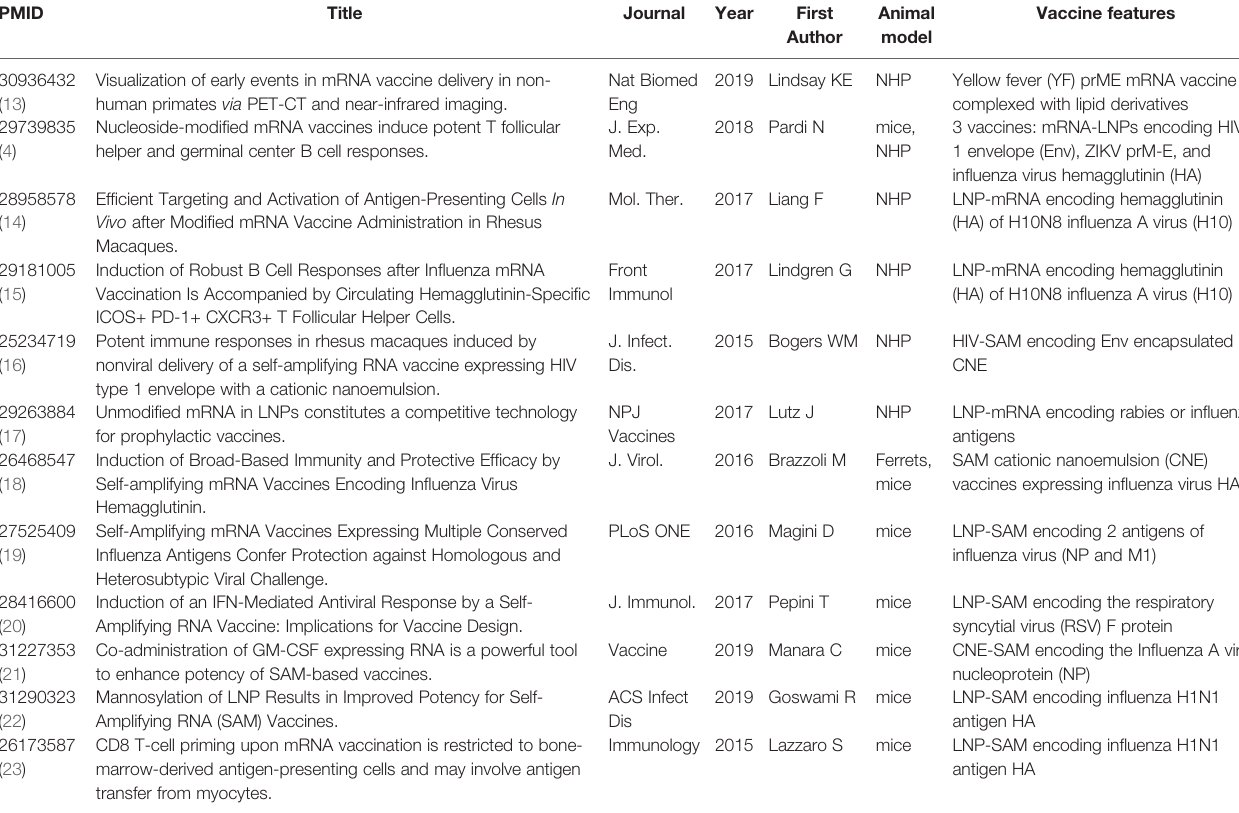
TABLE 1 | List of relevant scienti fi c literature studying mRNA-based vaccines in mouse and NHP animal models.